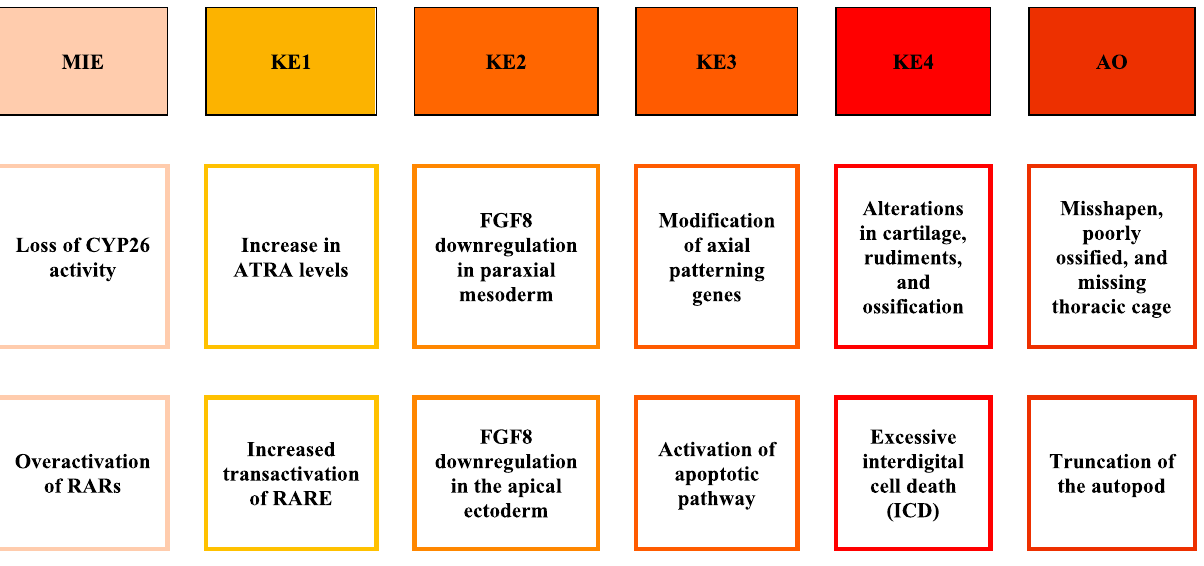
TABLE 3|pAOPsfor skeletaldysmorphogenesislinkedtodisruptionofretinoidsignaling. MIE, Molecular Initiating Event; KE,Key Events upstreamto downstream; AO, Adverse Outcome. MIEs included loss of CYP26 enzymatic activity/expression and overactivation of RARs. KEs are